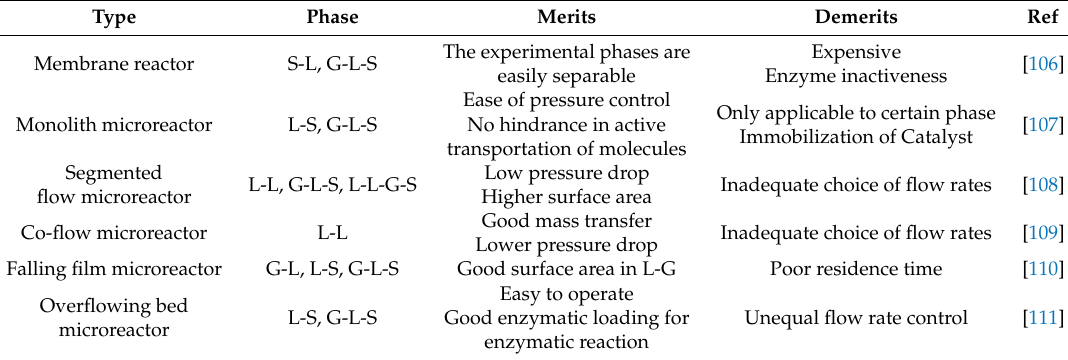
Table 2. Applications of microreactors in multiphase